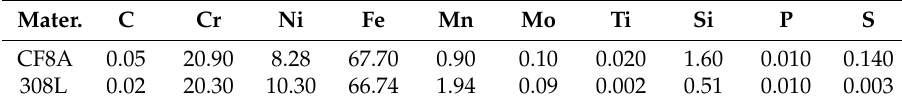
Table 1. Chemical compositions of the base metal and weld metals (mass %).